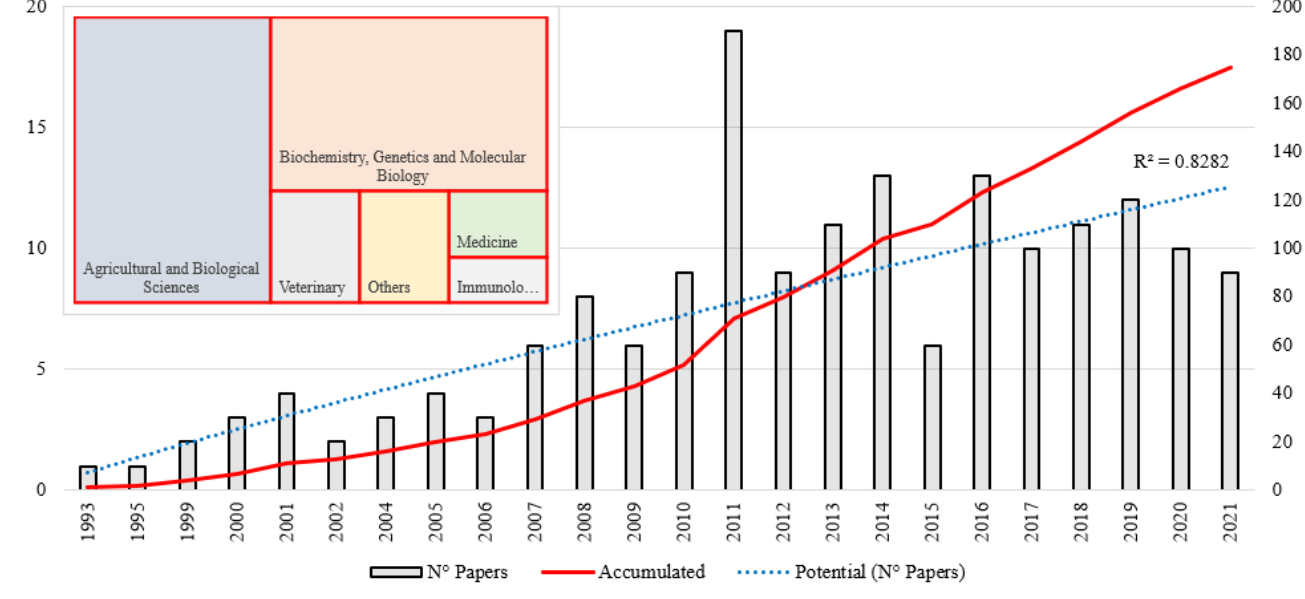
Figure 1. Papers published on the role of genetics in meat